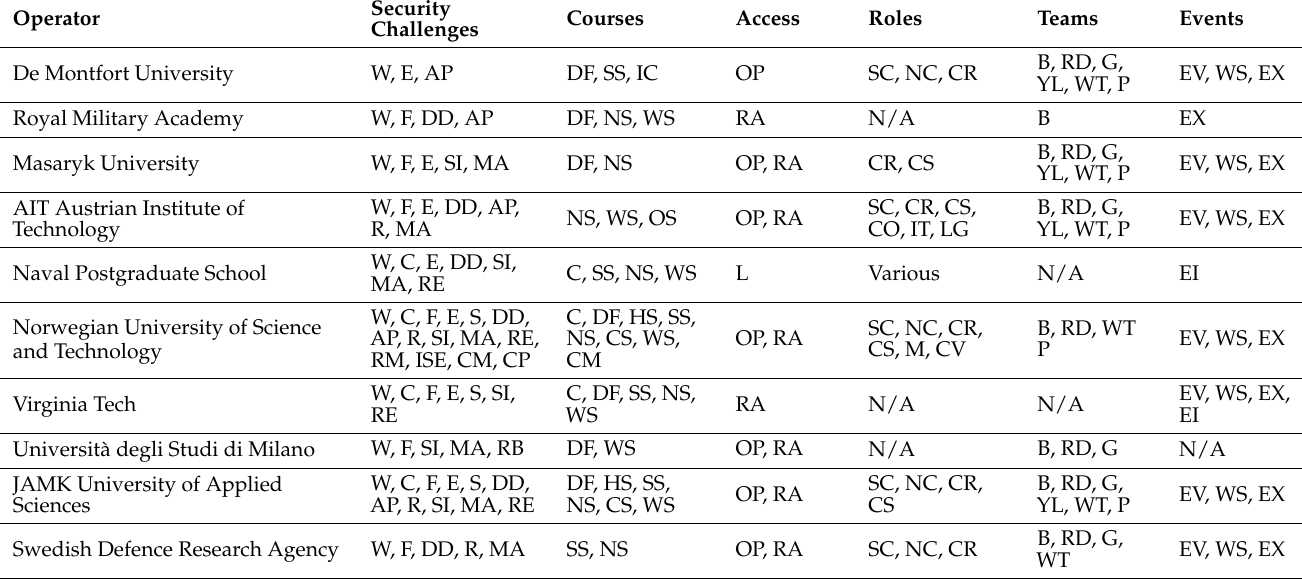
Table 3. Cyber Ranges’ features.